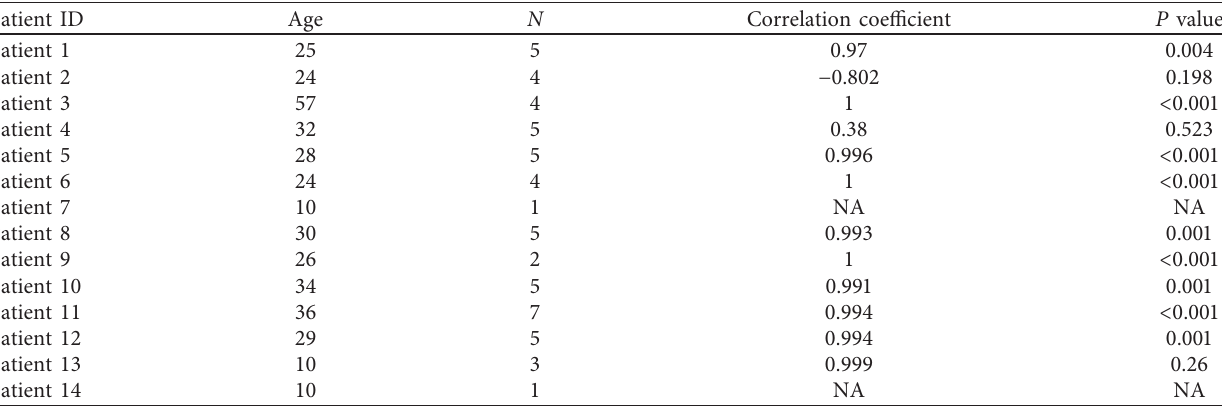
Table 3: The correlation between the one-stage assay and chromogenic assay for the measurement of factor VIII levels in the study cases.